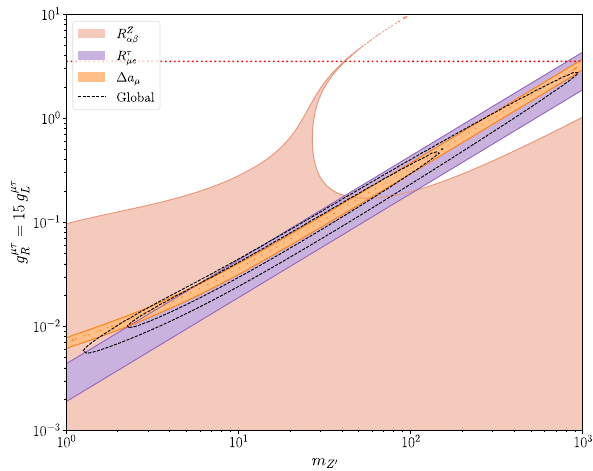
μτ − m ) parameter Z (cid:2) R μτ ∼ 15 × g μτ . The colour scheme R L μτ R